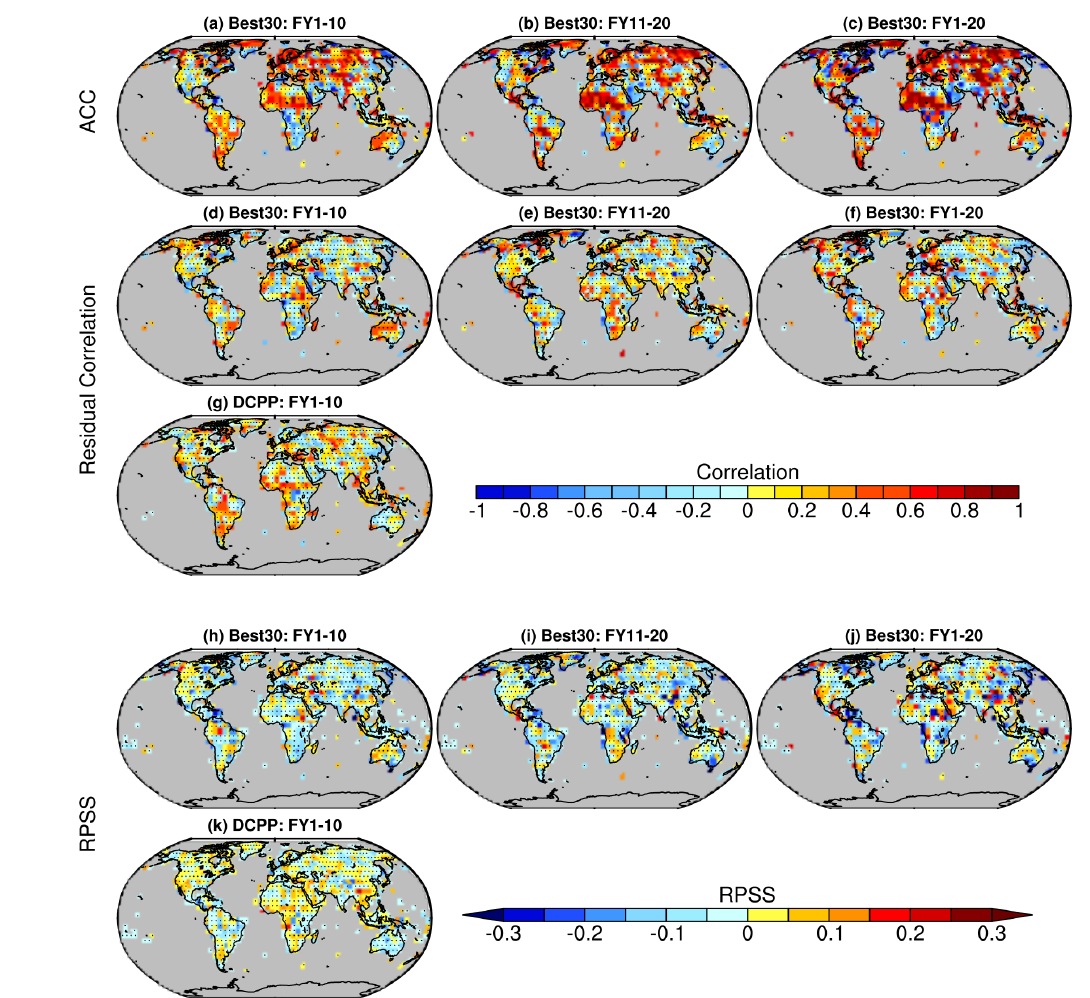
Figure 4. Anomaly correlation coefficient (ACC) between observed and predicted precipitation anomalies for three forecast periods, average of forecast years 1–10, 11–20, and 1–20 (a–c) . Residual correlations for Best30 (d–f) and for DCPP (g) ensemble means after removing the forced signal (estimated based on ensemble mean of the unconstrained 212 members following Smith et al., 2019). RPSS for Best30 (h–j) and for DCPP (k) against the unconstrained CMIP6 ensemble as reference. Stippling indicates regions where the ACC, residual correlation, and RPSS are statistically not significant at 95% confidence level (see Methods for